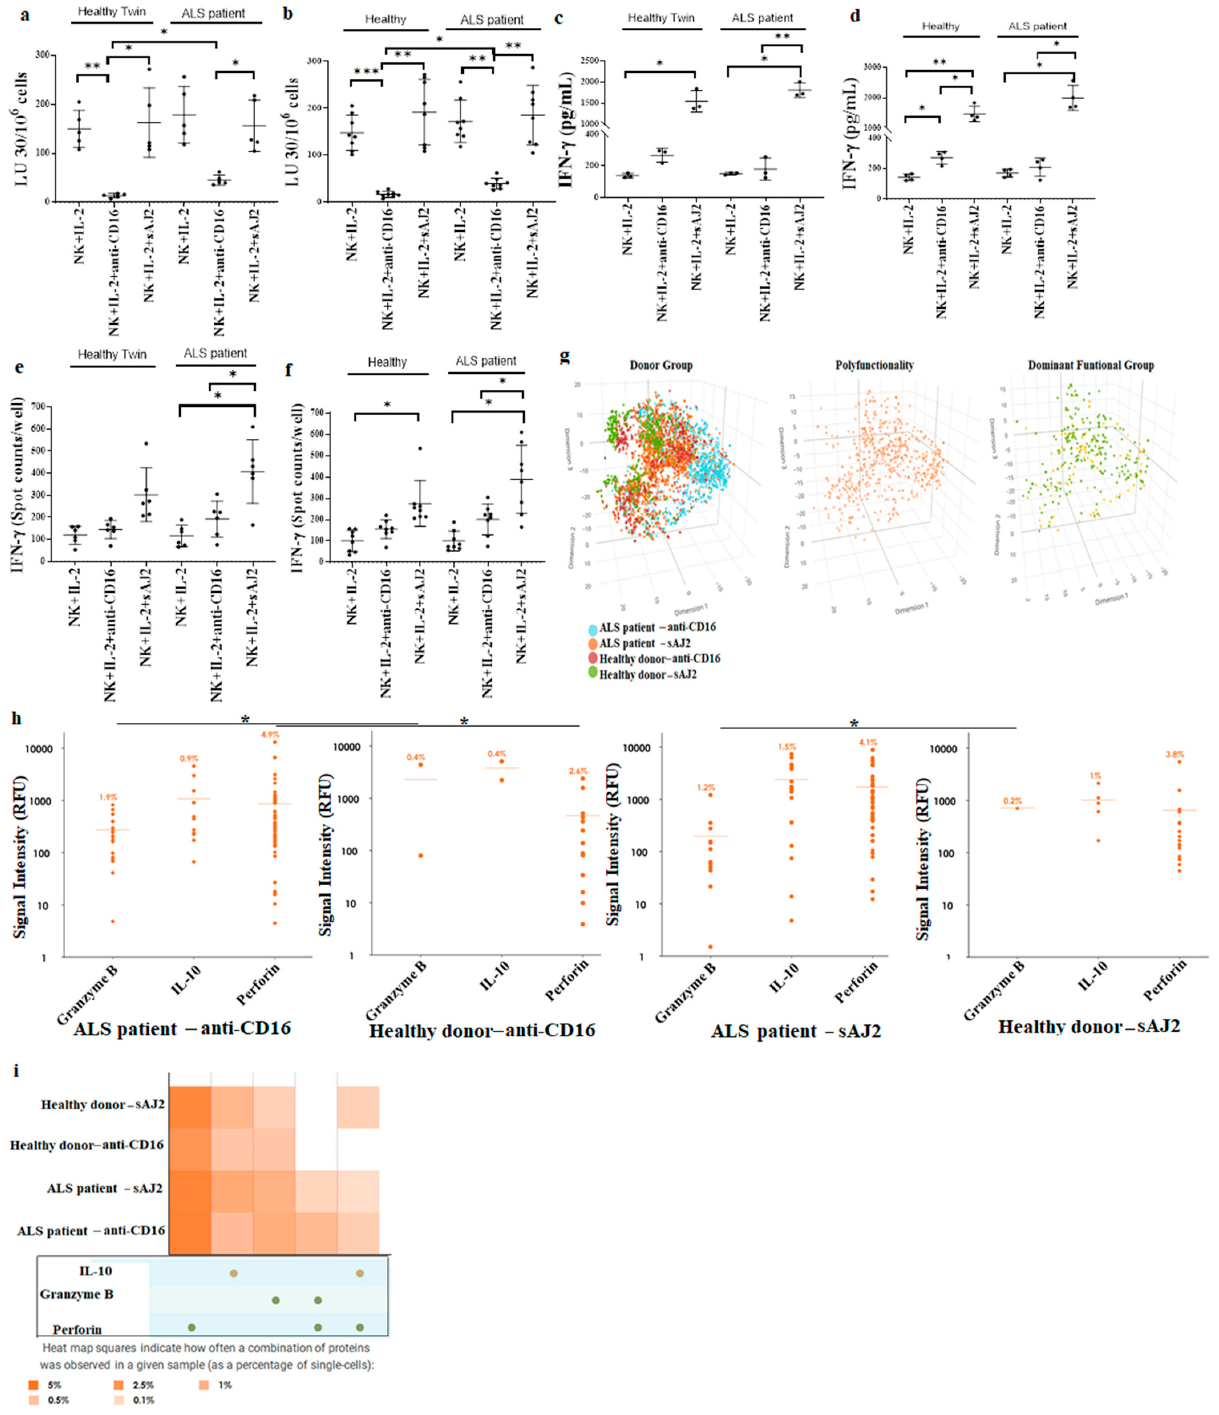
Figure 2. Increased NK cell-mediated cytotoxicity in IL-2 and anti-CD16mAb-treated NK cells from ALS patients. NK cells of healthy individuals and ALS patients were isolated from PBMCs as described in Section 2. NK cells (1 × 10 6 cells/mL) were treated with IL-2 (1000 U/mL) or with a combination of IL-2 (1000 U/mL) and anti-CD16 mAbs (3 µg/mL) or IL-2 (1000 U/mL) and sAJ2 (NK:sAJ2, 1:2) for 18 h before they were used in a standard 4 h 51 Cr release cytotoxicity assay against OSCSCs. The lytic units (LU) 30/10 6 cells were determined using the inverse numbers of NK cells required to lyse 30% of OSCSCs ×100 ( a ( n = 5), b ( n = 8)). NK cells were treated as described in Figure 2a, 18–20 h after treatments, the supernatants were harvested to determine IFN- γ secretion using single ELISA